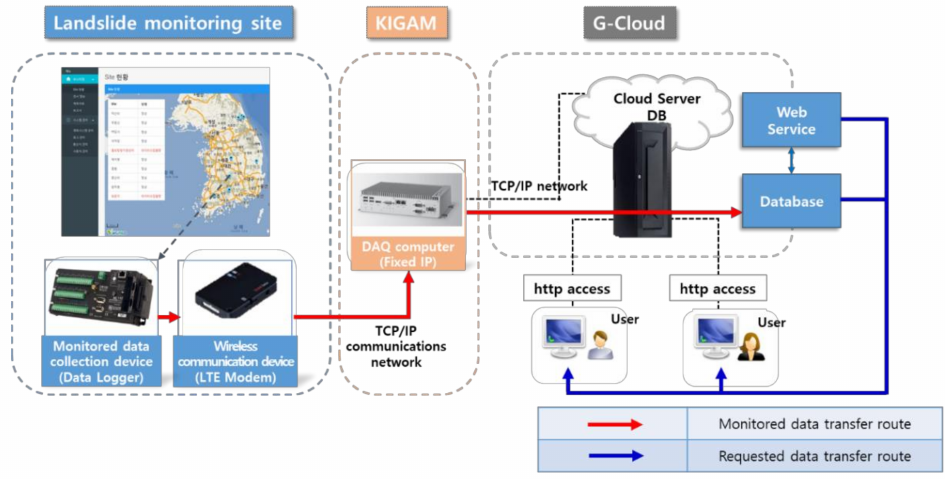
Figure 5. Architecture of data collection and transfer in KIGAM-LAMOS.